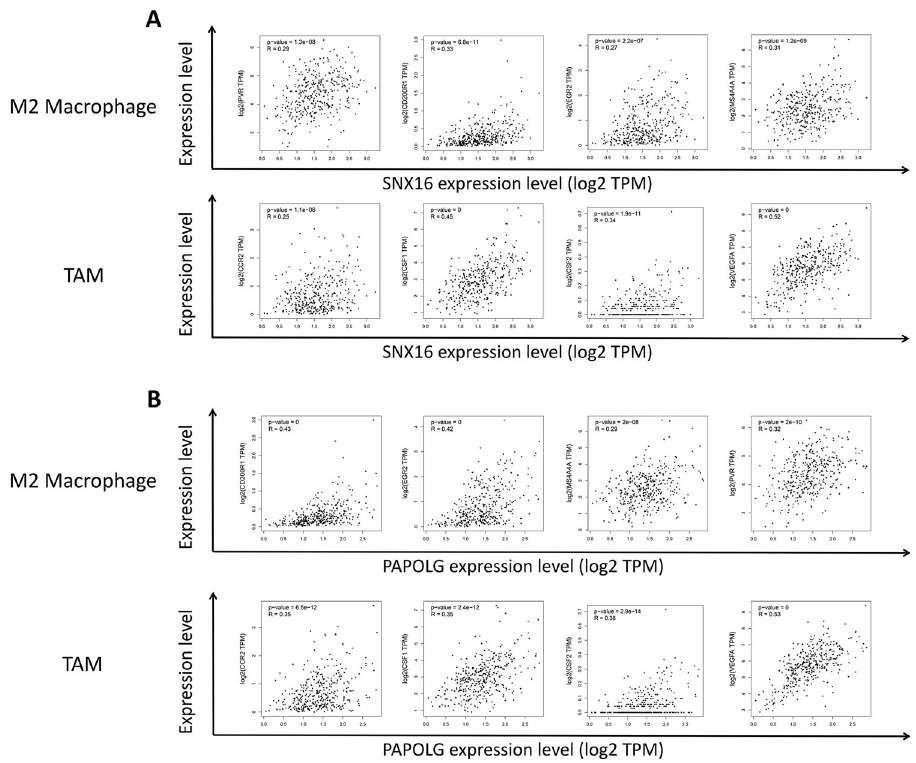
Fig 12. Effect of SNX16 and PAPOLG expression on macrophage polarization in HCC. Scatter plot of SNX16 (A) and PAPOLG (B) expression correlation with M2 macrophages (PVR, CD200R1, EGR2, MS4A4A) and tumor- associated macrophage (TAM) (CCR2, CSF1, CSF2, VEGFA) gene markers.